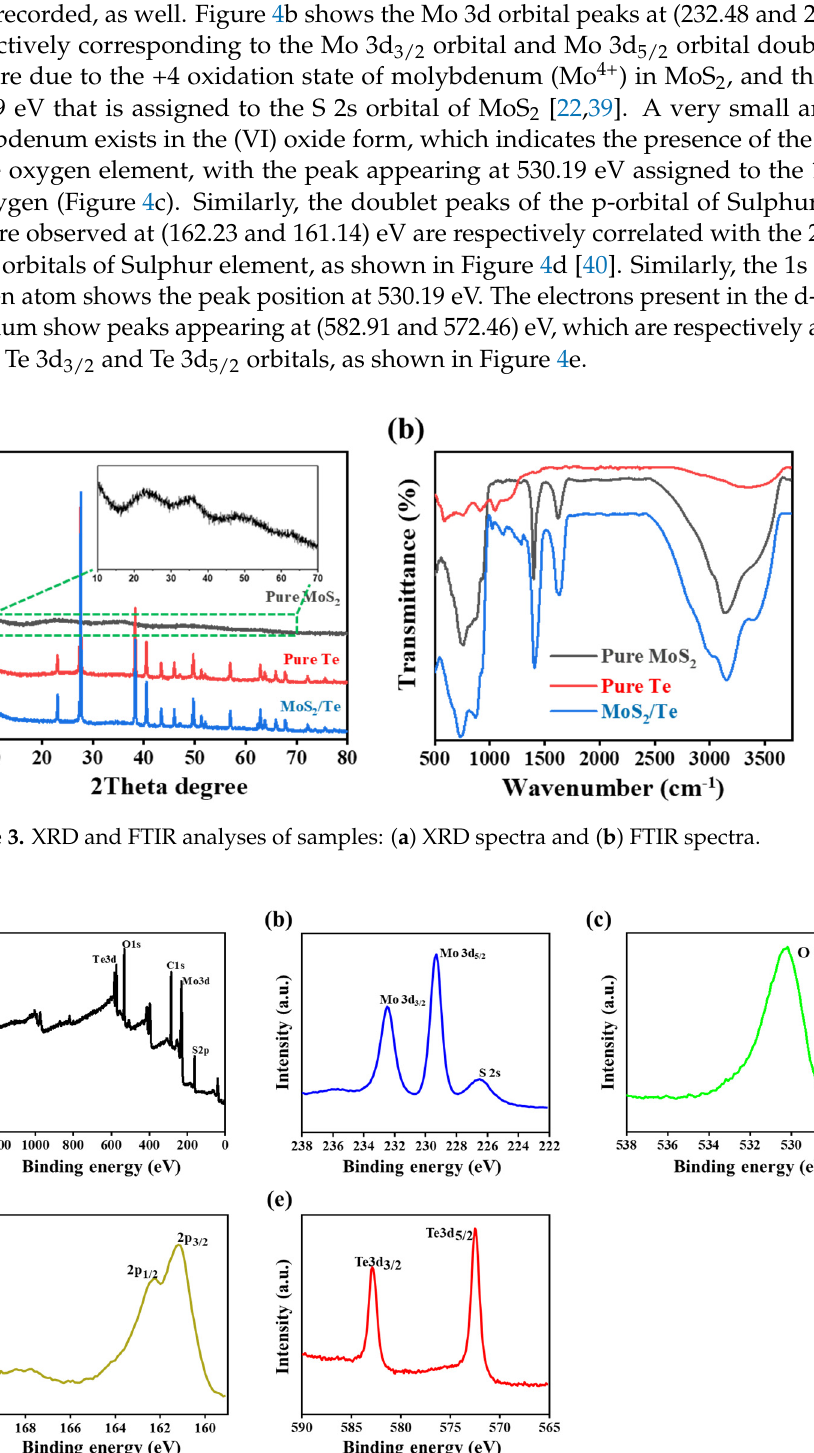
Figure 4. XPS spectra: ( a ) Survey spectrum, ( b ) Mo 3d, ( c ) O 1s, ( d ) S 2p, and ( e ) Te 3d.